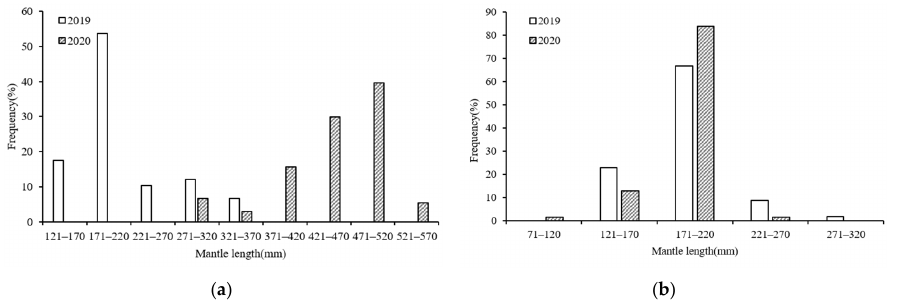
Figure 2. ML compositions of S. oualaniensis samples in different years: ( a ) female; ( b ) male.